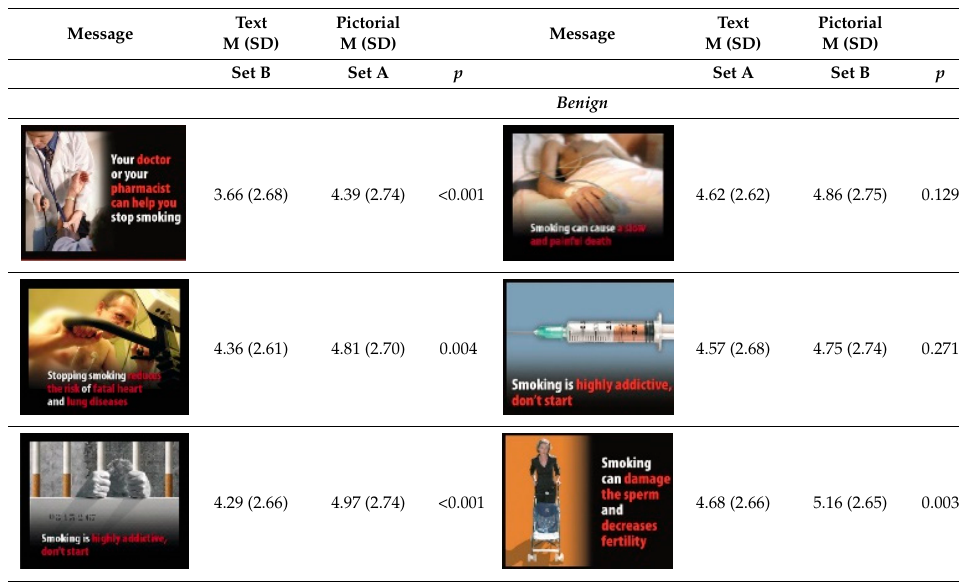
5 of 13 Table 1. Comparison of persuasiveness of graphic versus text-based messages. Message